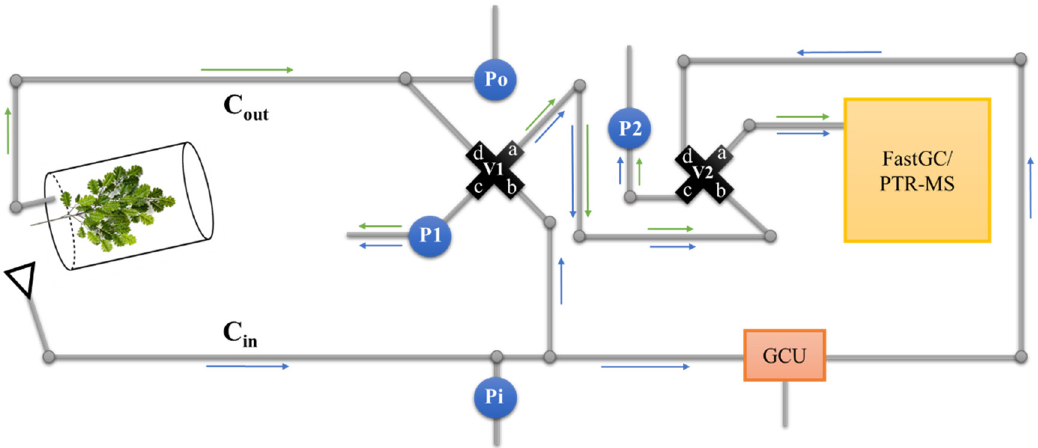
Figure 3. Schematic of the sampling system connecting a dynamic branch chamber to the FastGC/PTR-MS. Po and Pi stand for the pumps drowning the outlet and inlet air, respectively. P1 and P2 represent the flushing pumps connected to the valves V1 and V2, respectively. C In and C Out represent the incoming and the outgoing chamber air, respectively.